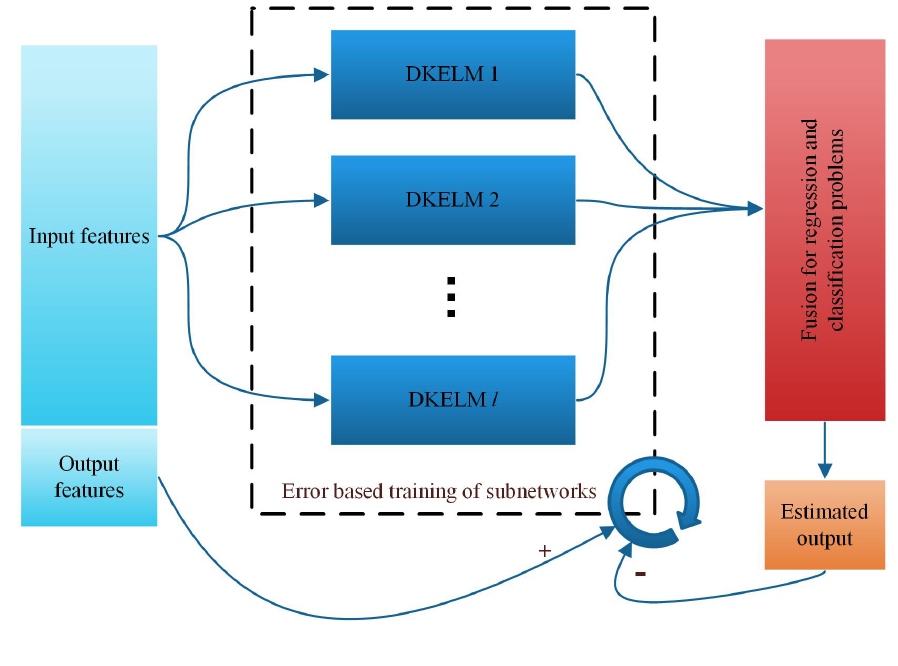
Figure 2. Distributed framework of proposed distributed kernel extreme learning machines (DKELMs)